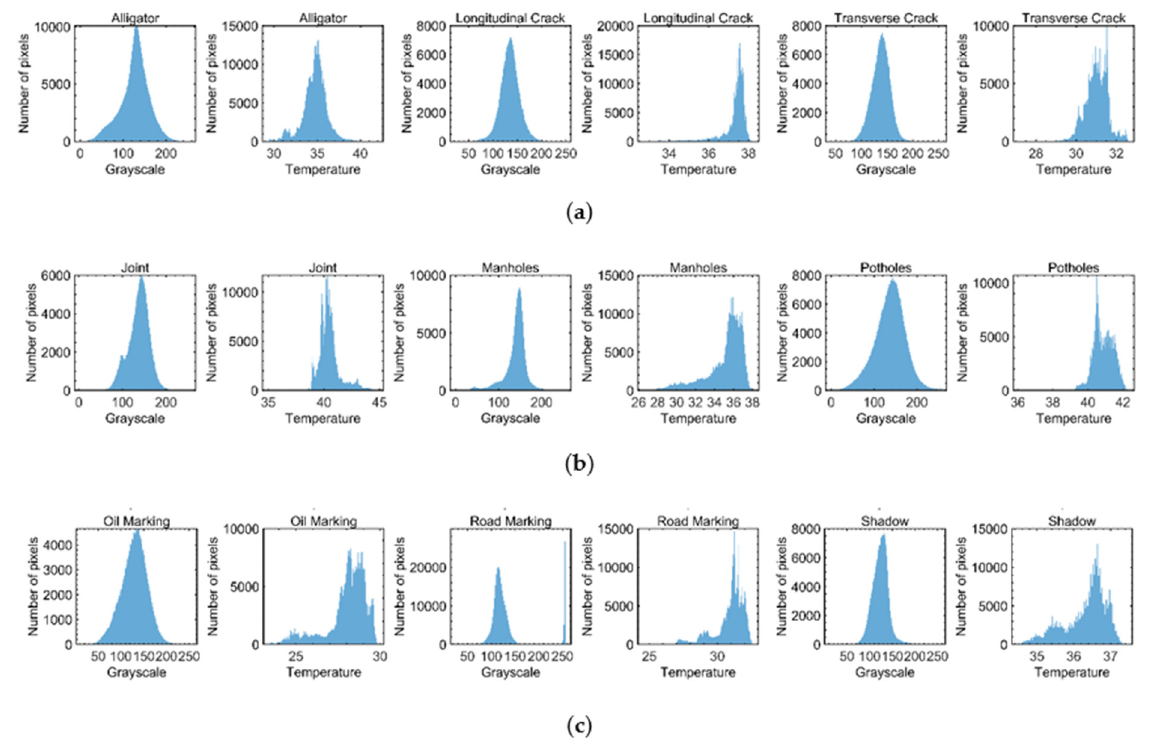
Figure 9. Numerical distribution of thermal image and RGB image. ( a ) Numerical distribution of thermal image and RGB image of alligator crack, longitudinal crack and transverse crack. ( b ) Numerical distribution of thermal image and RGB image of joint, manholes and potholes. ( c ) Numerical distribution of thermal image and RGB image of oil marking, road marking and shadow .